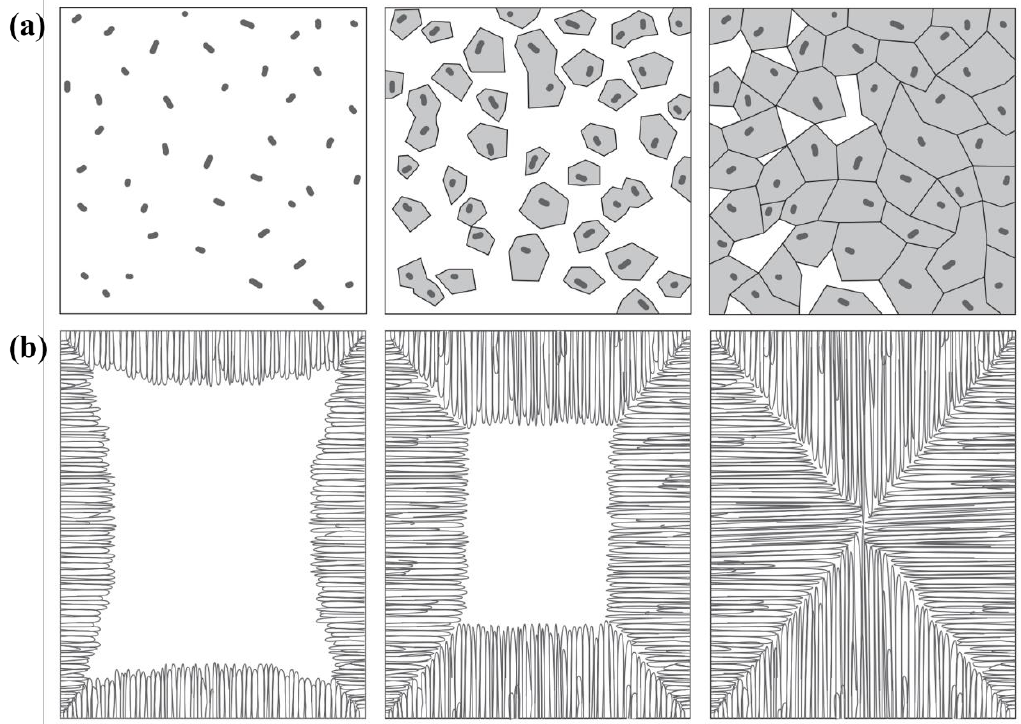
Figure 4. ( a ) Bulk crystallization. ( b ) Surface crystallization. Reprinted with permission from Ref. [22].